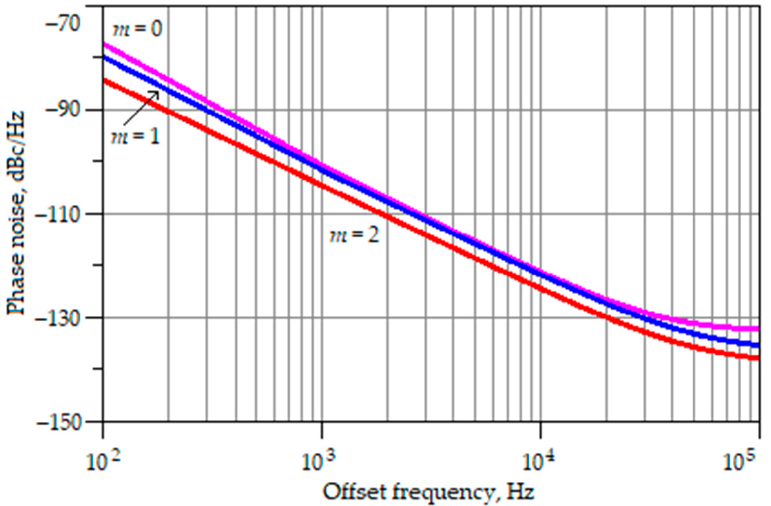
Figure 23. Phase noise versus offset frequency for VCO with multiple-output improved Wilson current mirror when V d = 2 V, R L = ∞ ; m = 0—purple curve ( C a = 10 pF), m = 1—blue curve ( C a = 7 pF), m = 2—red curve ( C a = 6 pF).